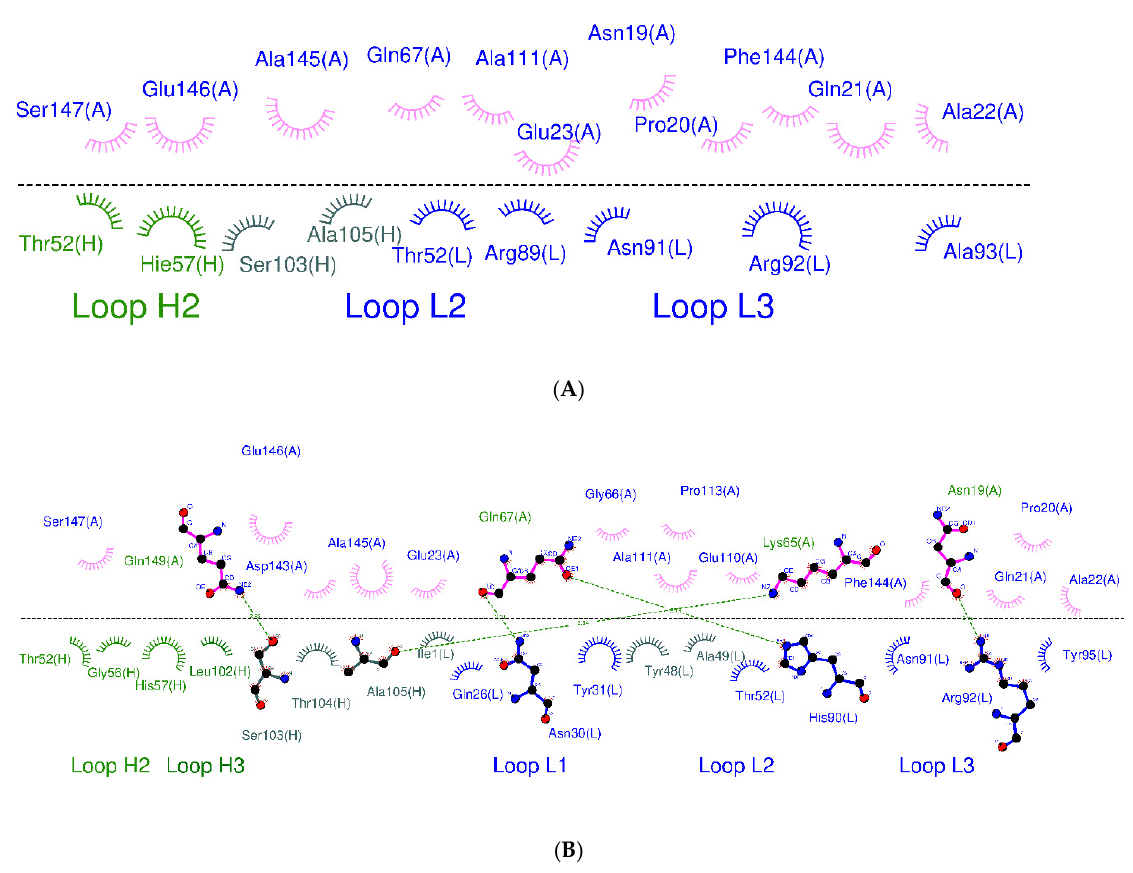
Figure 5. Binding mode analysis of W1-Humira–TNF alpha. ( A ) W1-Humira at pH 6.0 and ( B ) W1-Humira at pH 7.4. (H: heavy chain; L: light chain; A: TNF alpha). Table 3. Possible binding modes (residues) of W1-Humira at pH 7.4 and 6.0 with TNF alpha. (HCDR1: 30th–35th residue; HCDR2: 50th–66th residue; HCDR3: 99th–110th residue; LCDR1: 24th–34th residue; LCDR2: 50th–56th residue; LCDR3: 89th–97th residue).